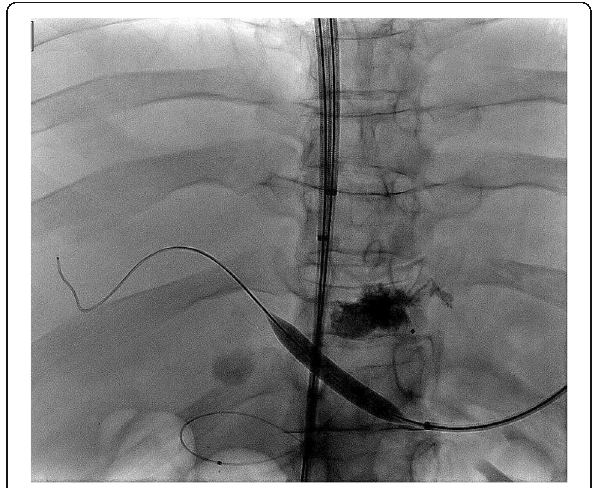
Fig. 3 Fluoroscopic image showing balloon angioplasty of recanalized portal vein using a transsplenic approach